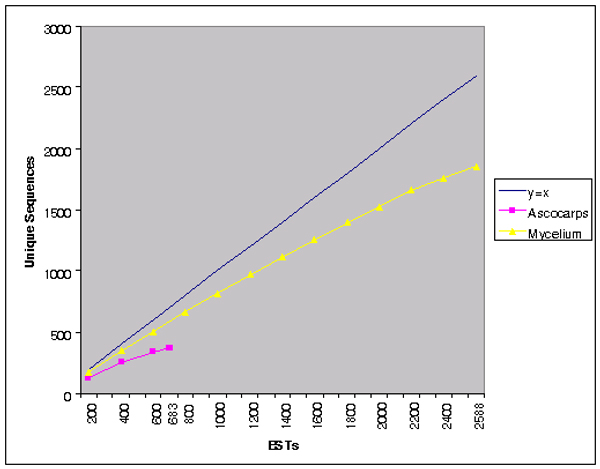
Discovery rates for the ascocarp and mycelium datasets. Organ unique sequences plotted against the number of ESTs. The discovery rate is represented by the angular coefficient of the line connecting two consecutive points. The straight line (y=x) corresponds to a discovery rate of 1.